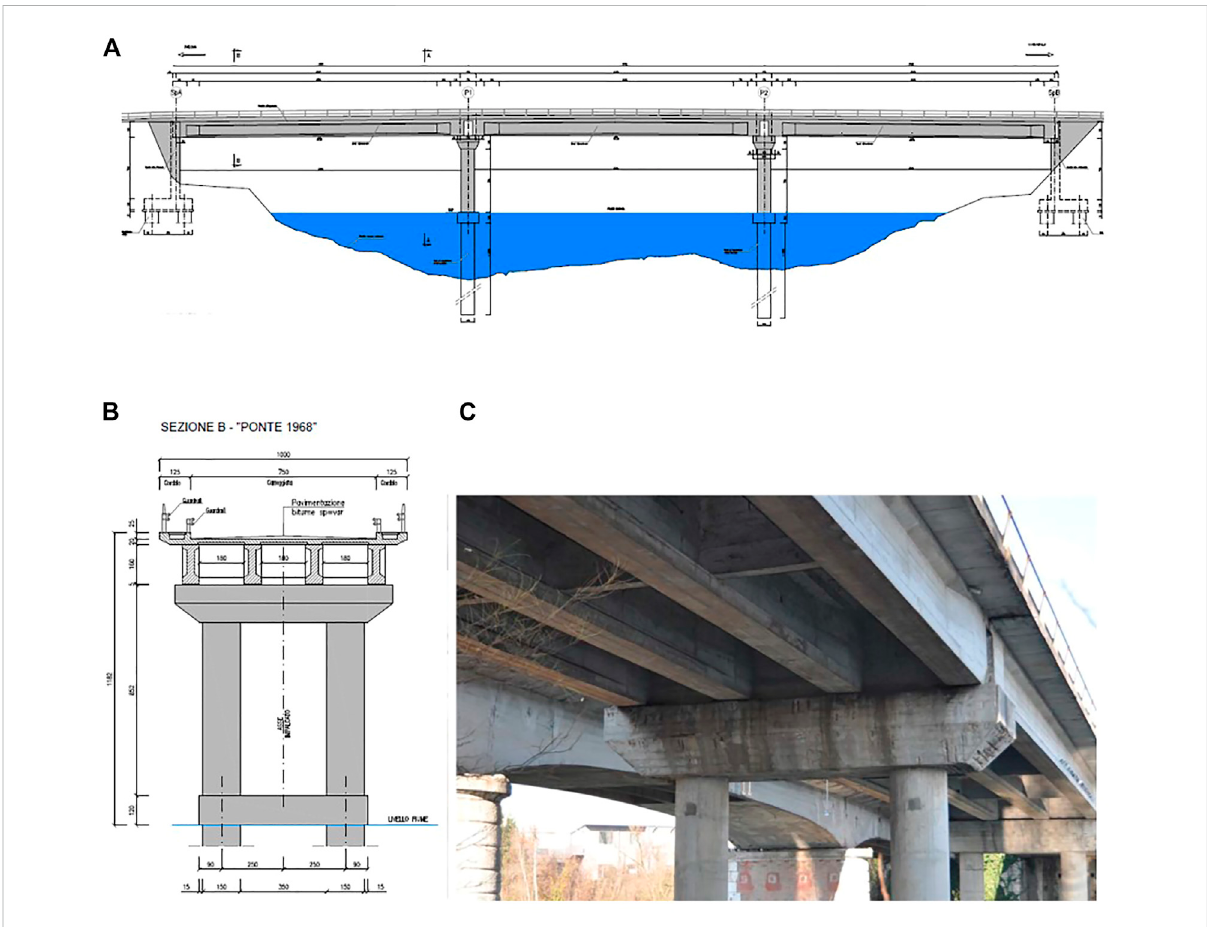
FIGURE 8 Case study: four PTC beams of a 50-year bridge with post-tensioned tendons and grouted ducts: (A) longitudinal view, (B) transversal cross- section, and (C) detail of the current condition state.